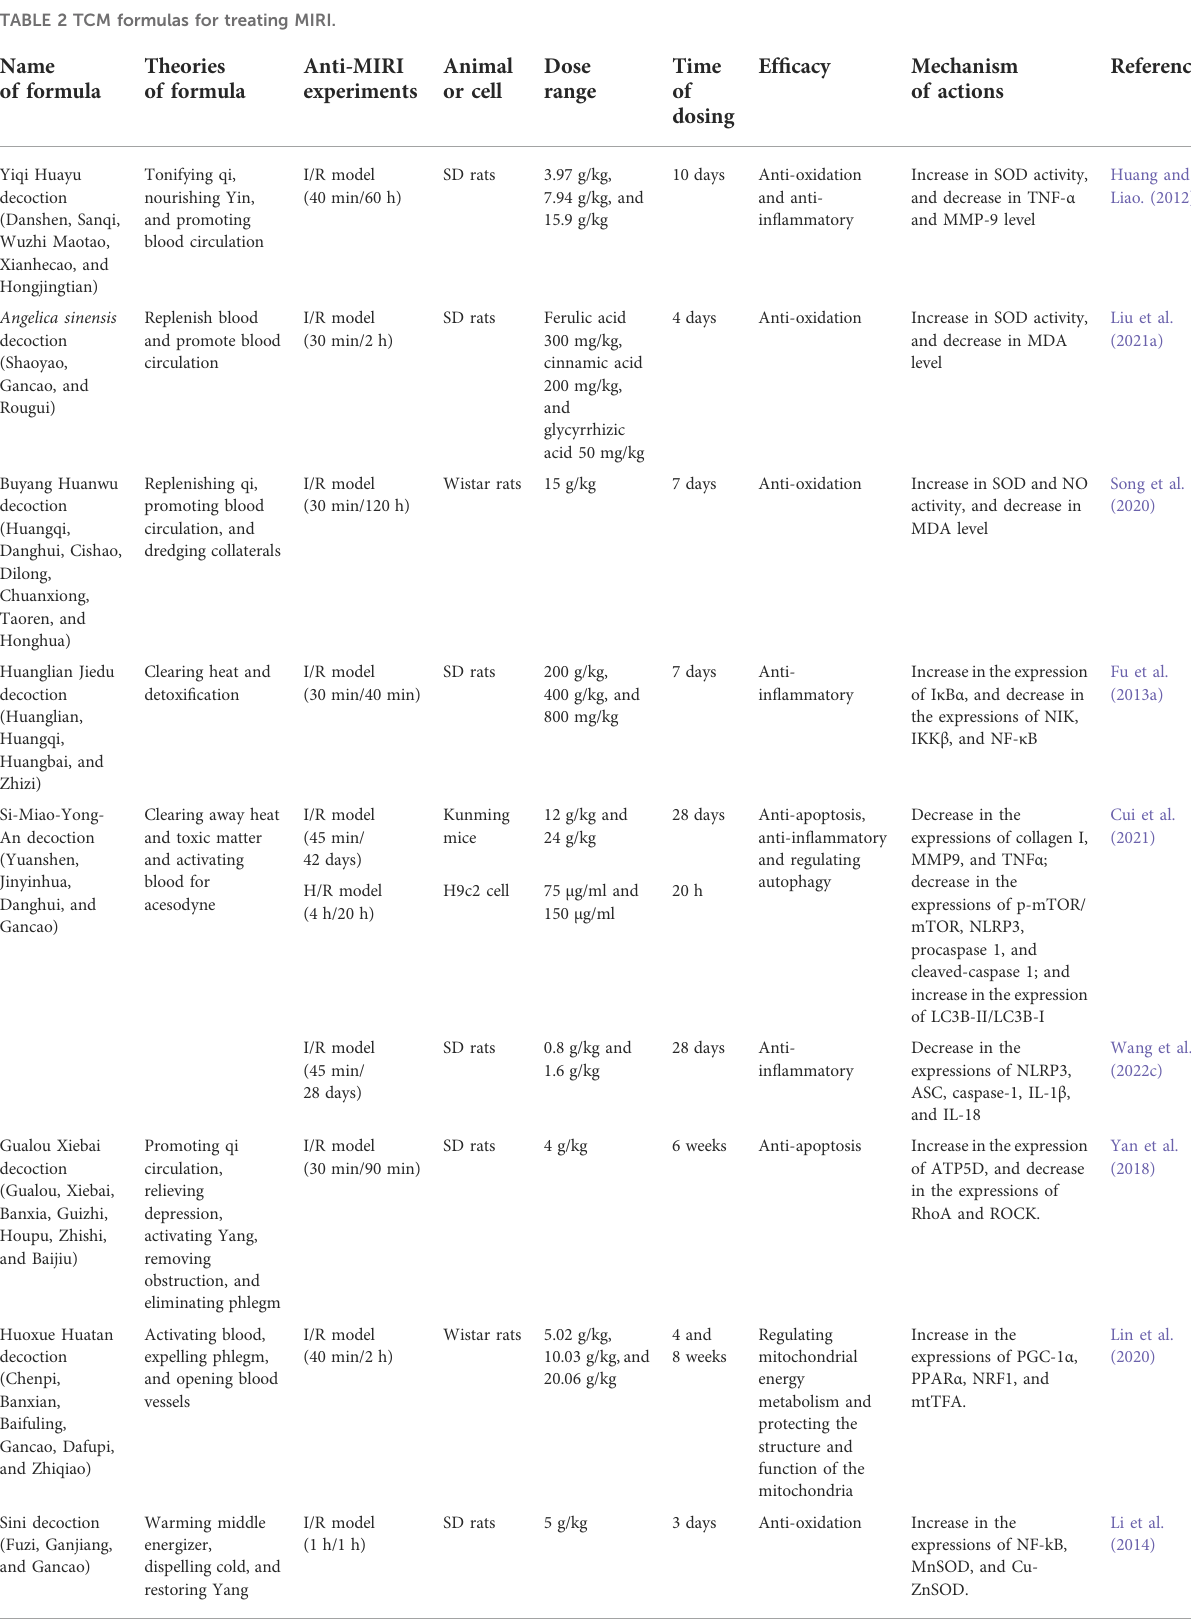
TABLE 2 TCM formulas for treating